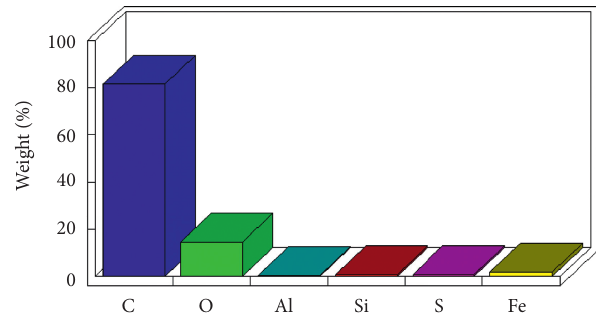
Figure 4: Quantitative results for